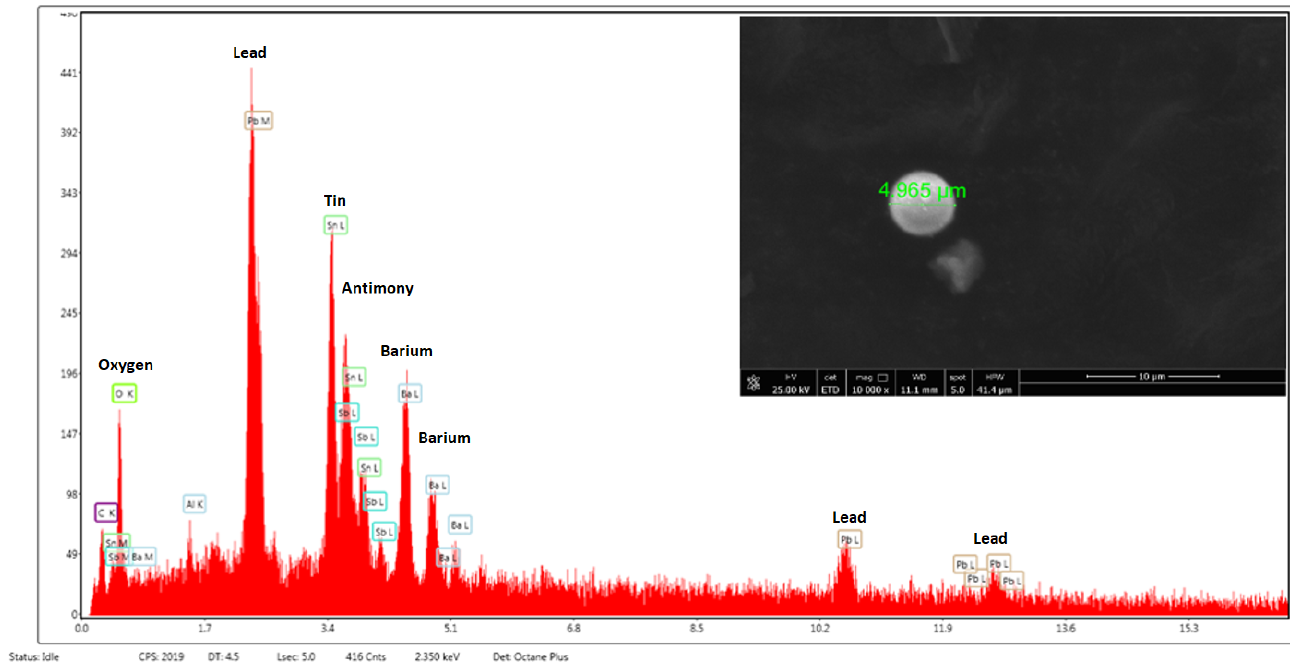
Figure 1. A typical SEM picture and EDS spectrum of GSR particles generated from the discharge of a high-caliber firearm (model: Zastava M70AB2 rifle; cal. 7.62 × 39 mm).